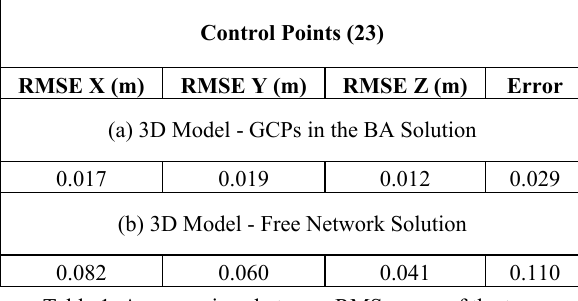
Table 1. A comparison between RMS errors of the two photogrammetric models with all the acquired photos.